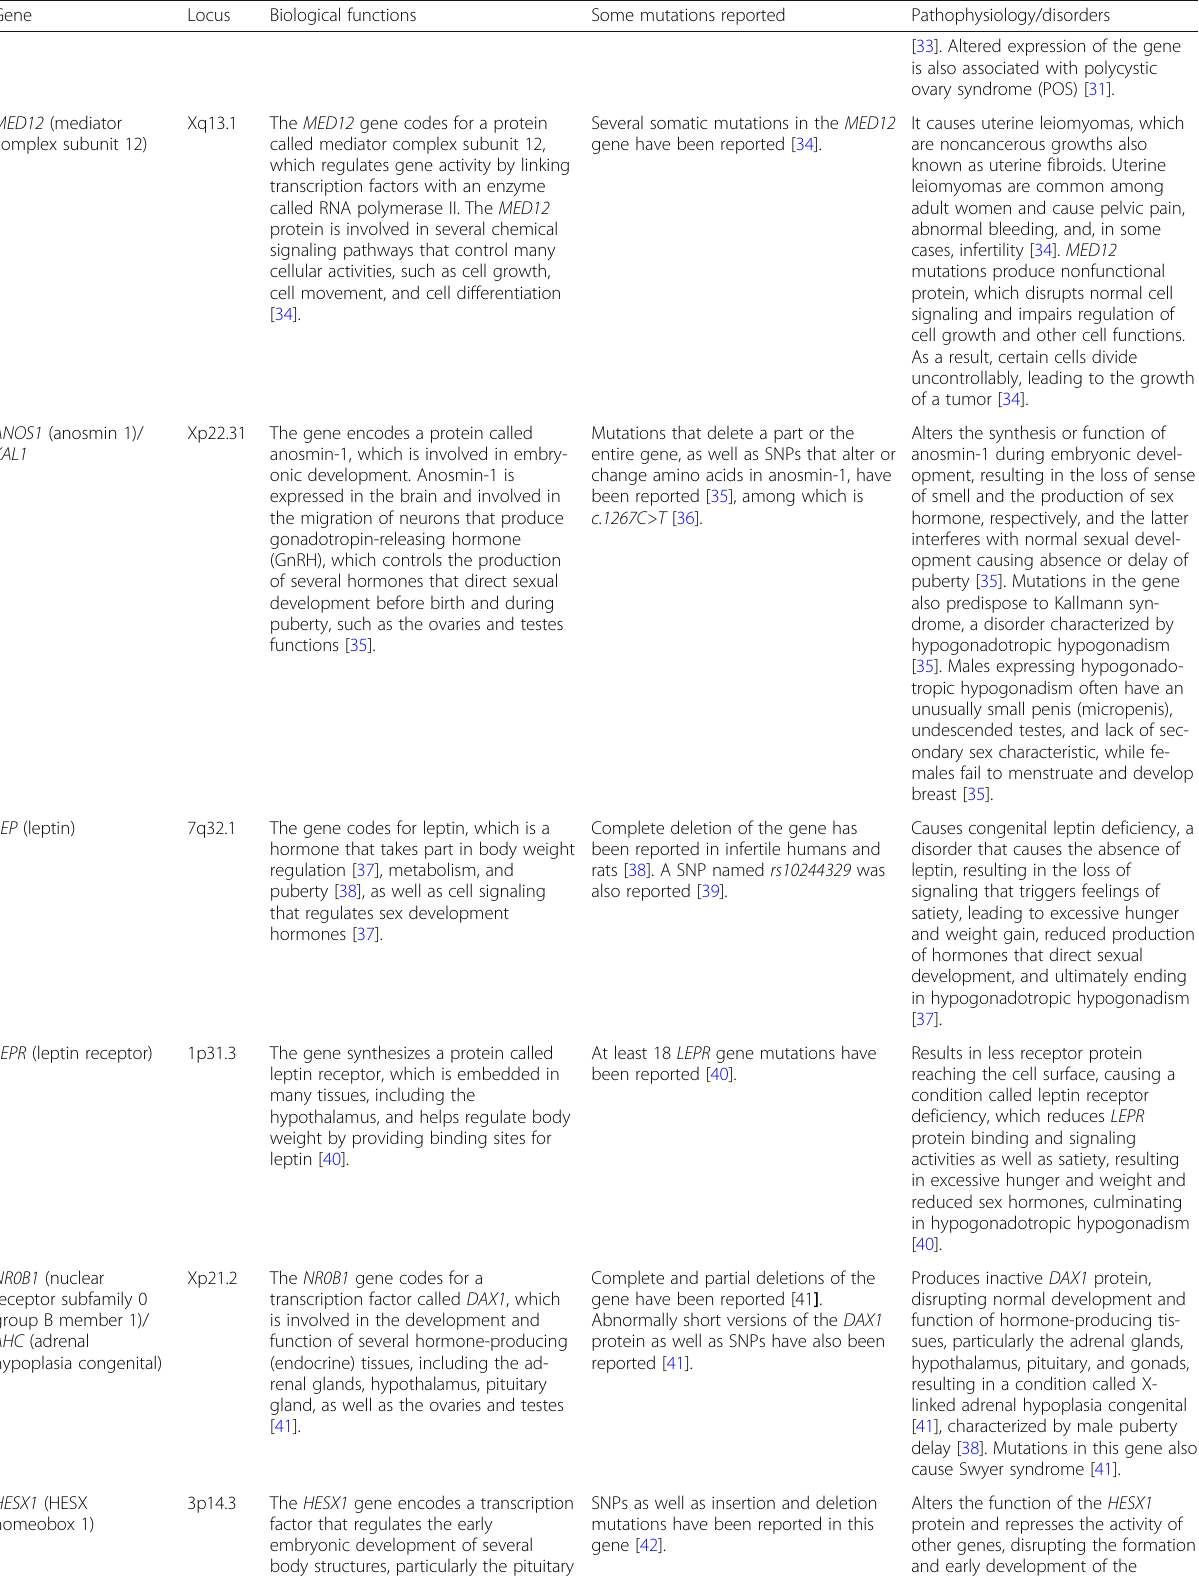
Table 1 Genes predisposing to syndromic infertility (Continued)